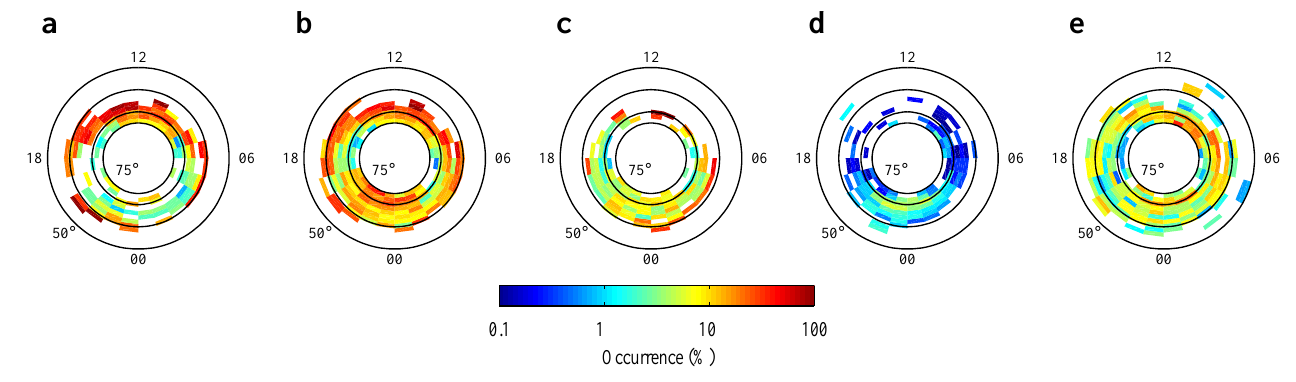
Fig. 4. Probabilities of detecting energized ions versus MLT and INV in the presence of ( a ) precipitating keV protons, ( b ) suprathermal electron bursts, ( c ) downward moving keV electrons, ( d ) low magnetic activity, K p < 3 − , and ( e ) high magnetic activity, K p > 4 + . The colour scale is the same as in Figs.